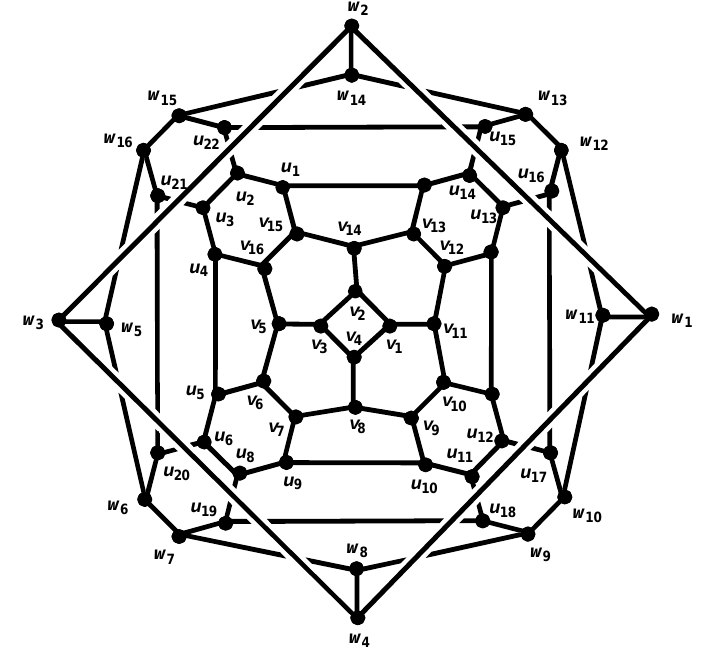
Figure 5. Labeling of the polyhedral graph